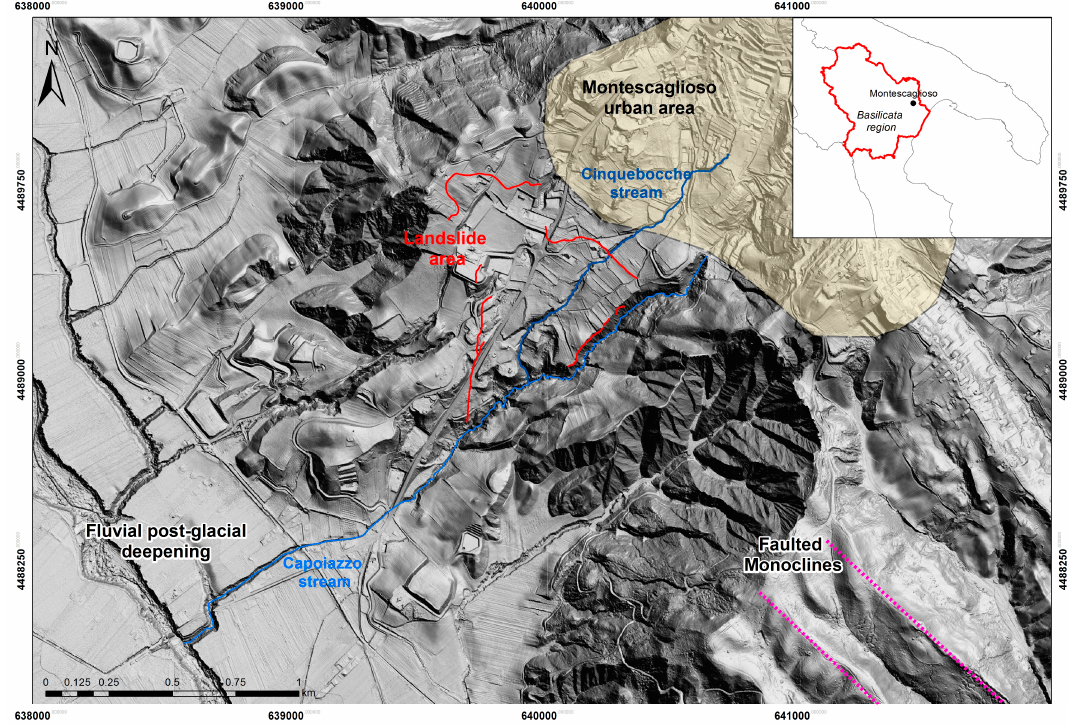
Figure 1. Hillshaded digital terrain models (DTM) of Montescaglioso area, with the location of the landslide.